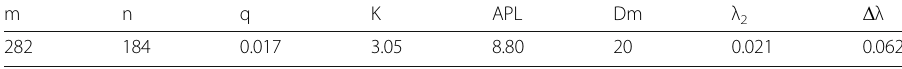
Table 1 Topological characteristics of the water distribution network of